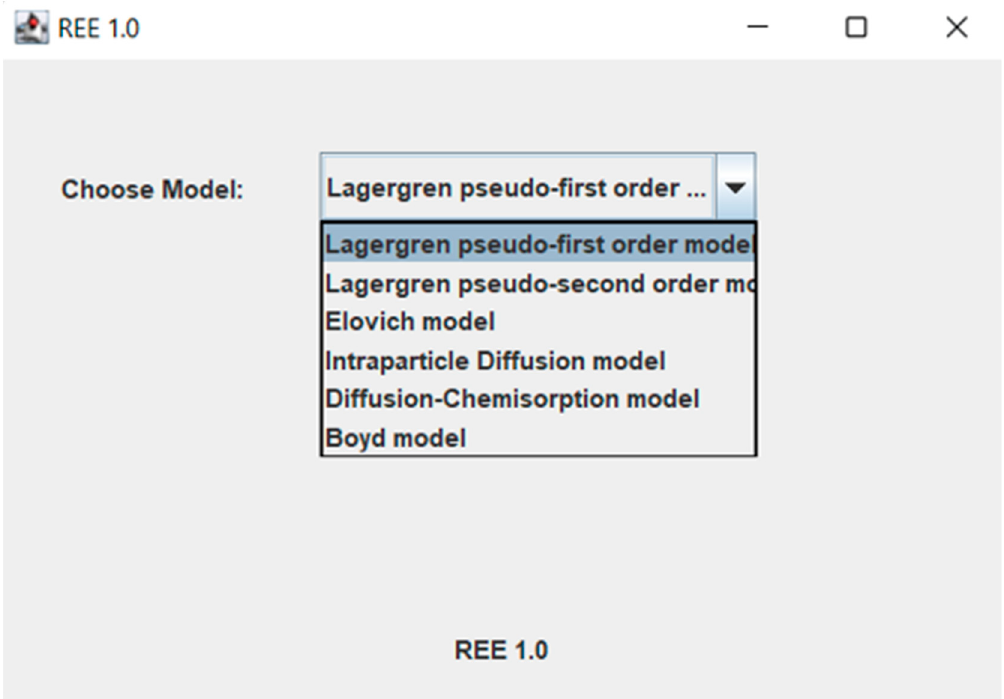
Figure 1. Main window for kinetic model or adsorption mechanism model